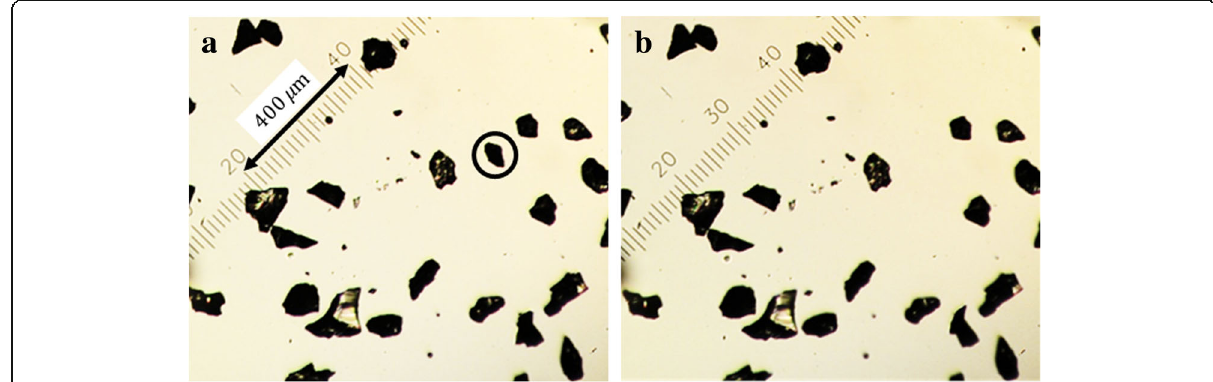
Fig. 4 Optical microscope images of alumina particles ( a ) before and ( b ) after applying a centrifugal force at a rotation speed of 300 rpm. A particle in a circle in image ( a ) detached during the rotation and did not exist on the Petri dish in image ( b